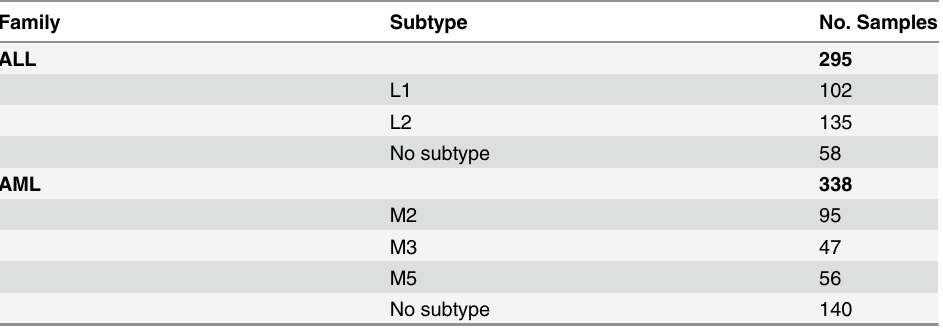
Table 2. Samples by subtypes.